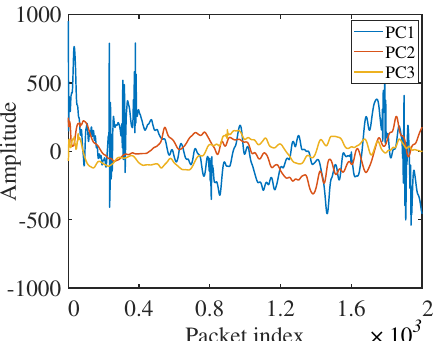
Figure 5. De-noising the PCs of 4 persons (a 4-level db3 wavelet).